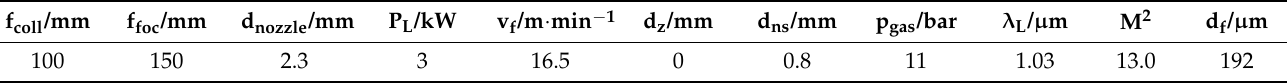
Table 3. Laser-cutting